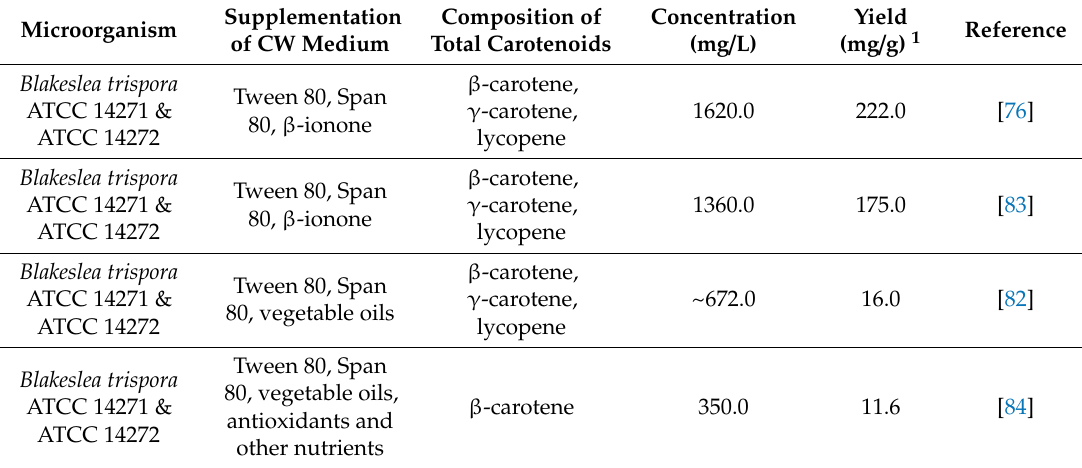
Table 1. Carotenoid production from various microorganisms through fermentation in cheese whey